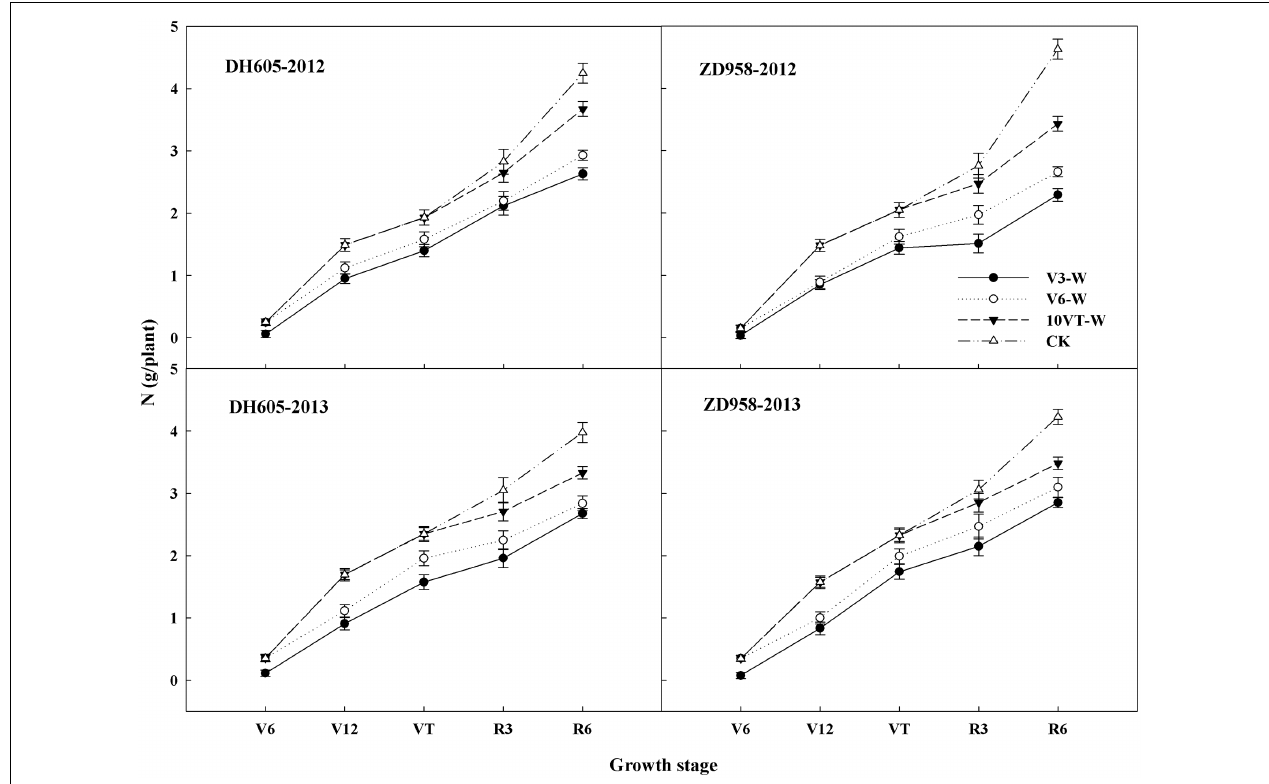
FIGURE 1 | Effects of waterlogging on the N accumulation of maize. V3-W: waterlogging at the third leaf stage; V6-W: waterlogging at the sixth leaf stage; 10VT-W: waterlogging at 10th day after the tasseling stage. Means and standard errors based on three replicates are shown.